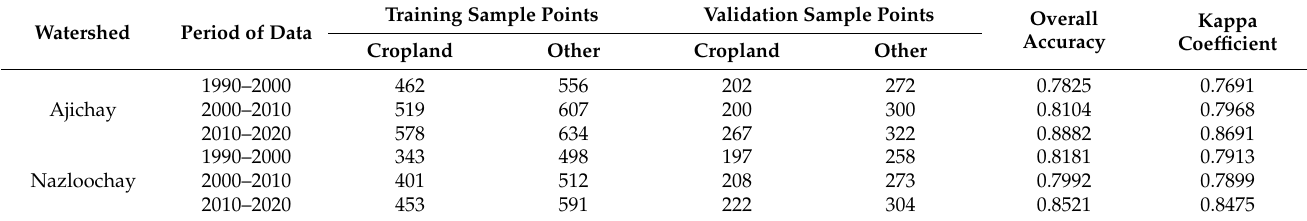
Table 8. Mann–Kendall Z-values and correlation coefficients of annual time